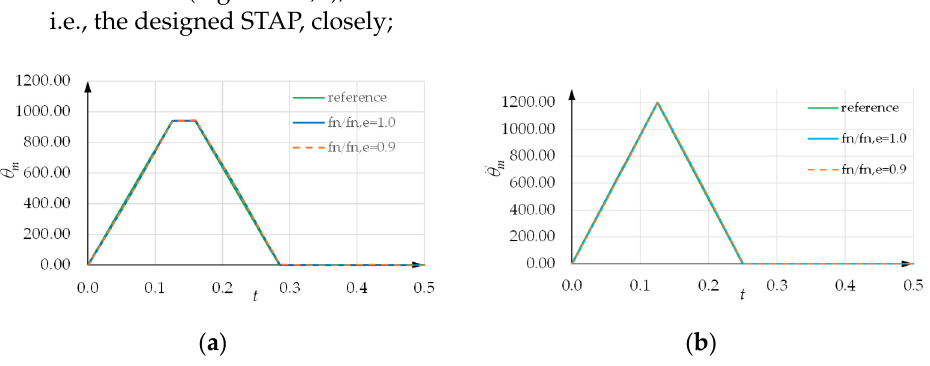
Figure 21. Motor acceleration versus time: ( a ) J L / J M = 1.00; ( b ) J L / J M = 0.25.